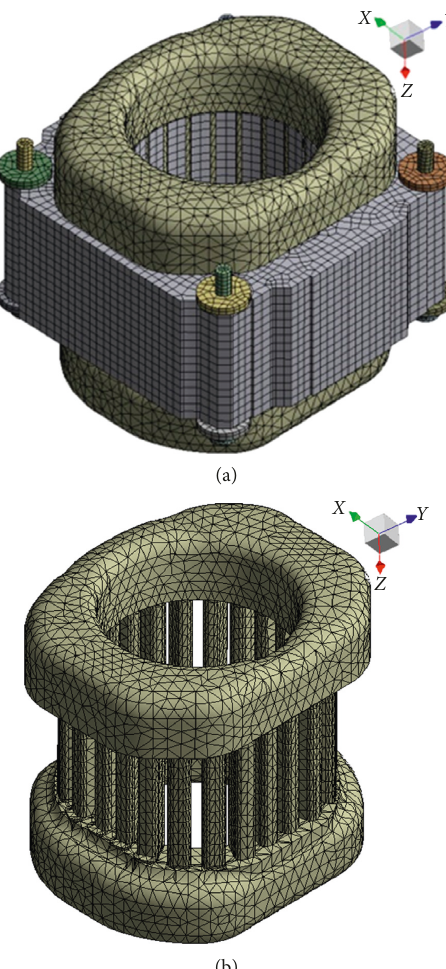
Figure 10: (a) Full numerical model of the stator, with the physical presence of the winding and (b) isotropic volume of the